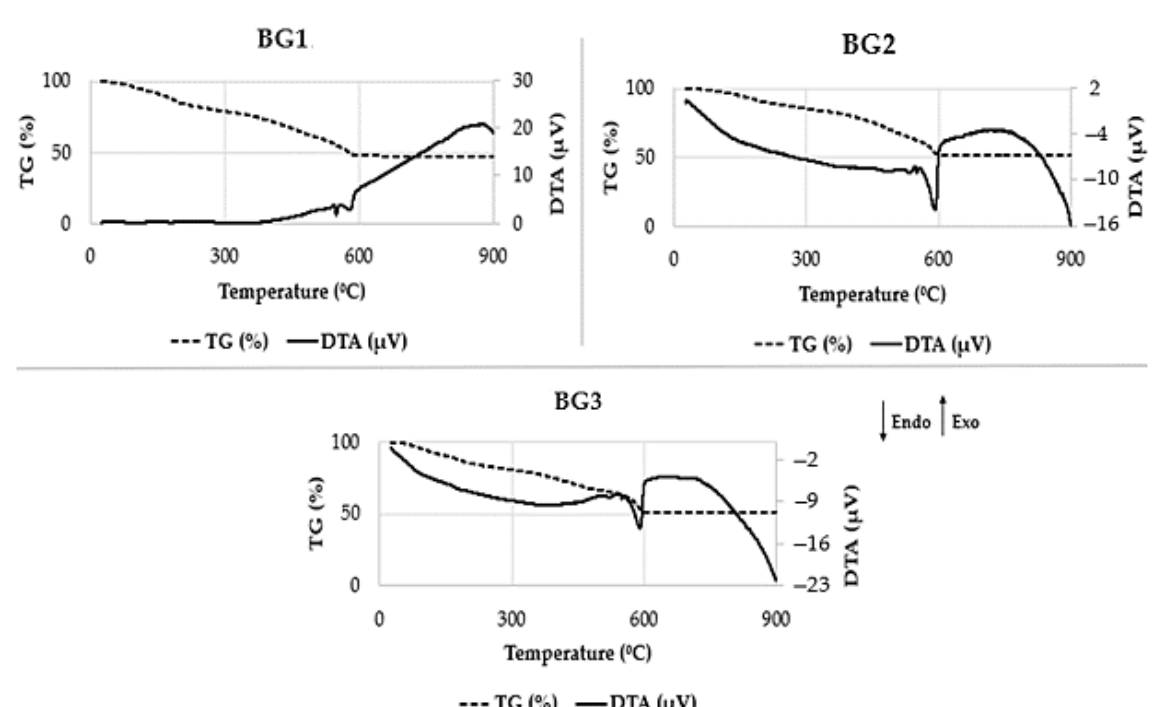
Figure 1. TG/DTA of BG1, BG2, and BG3 powder samples. Initial weight of BG samples: 1 (8.307 mg), 2 (11.391 mg), and 3 (9.353 mg).